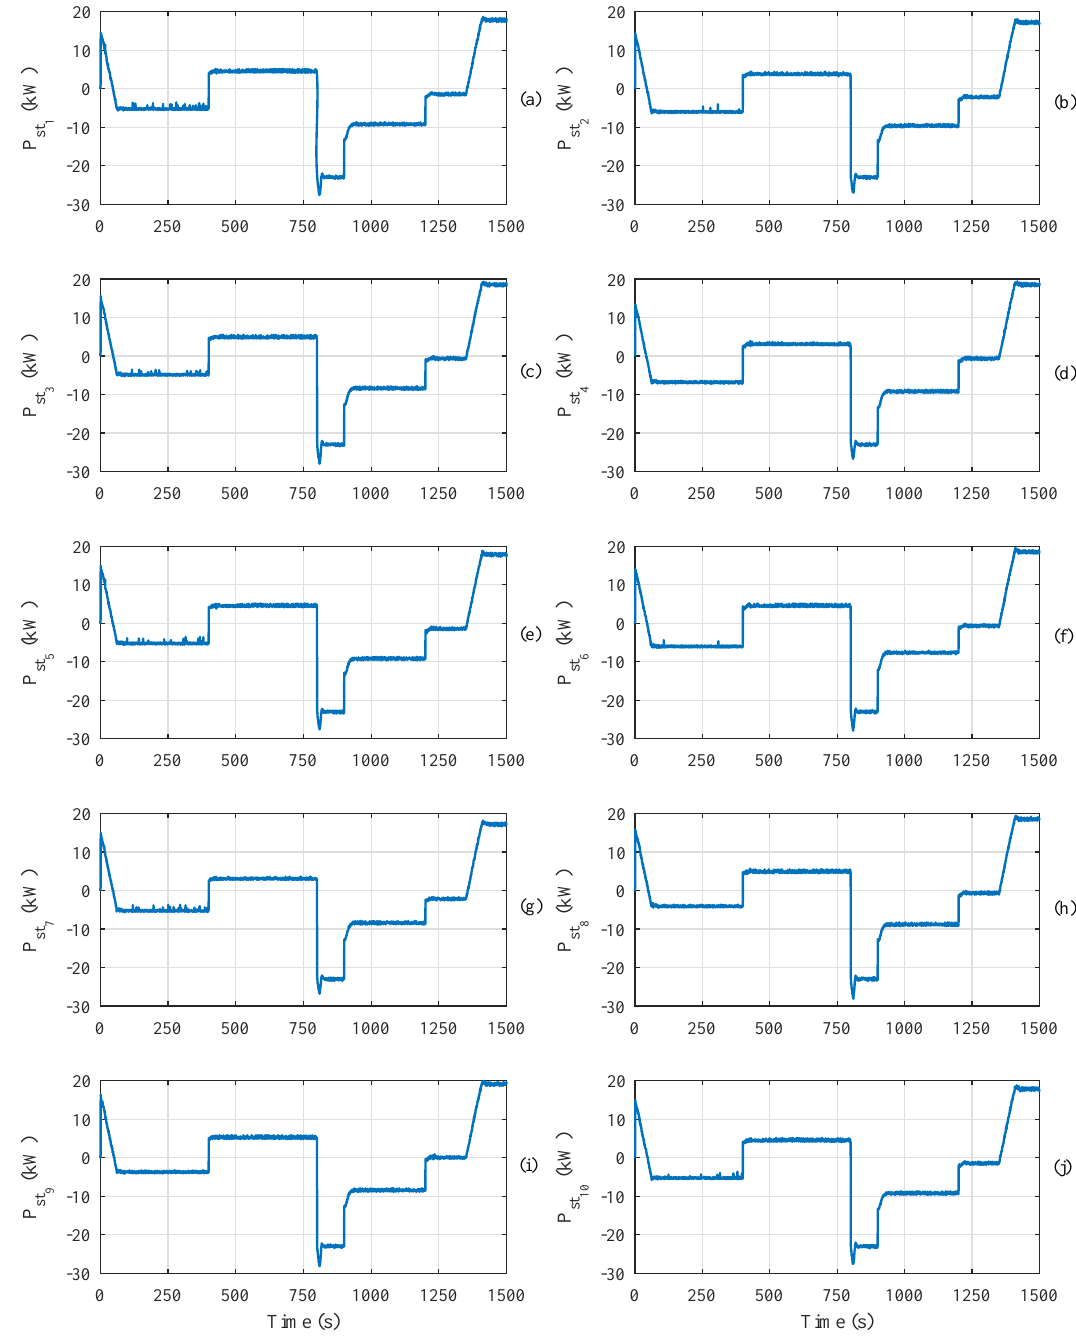
Figure 16. Time responses of the power exchanged by the 10 hybrid energy storage systems (HESSs). ; ( d ) p st ; ( e ) p st ; ( f ) p st ; ( g ) p g ; ( h ) p st ; ( i ) p st ; and ( j ) p st ; ( b ) p st ; ( c ) p st ( a ) p st 7 6 8 9 2 3 5 1 4